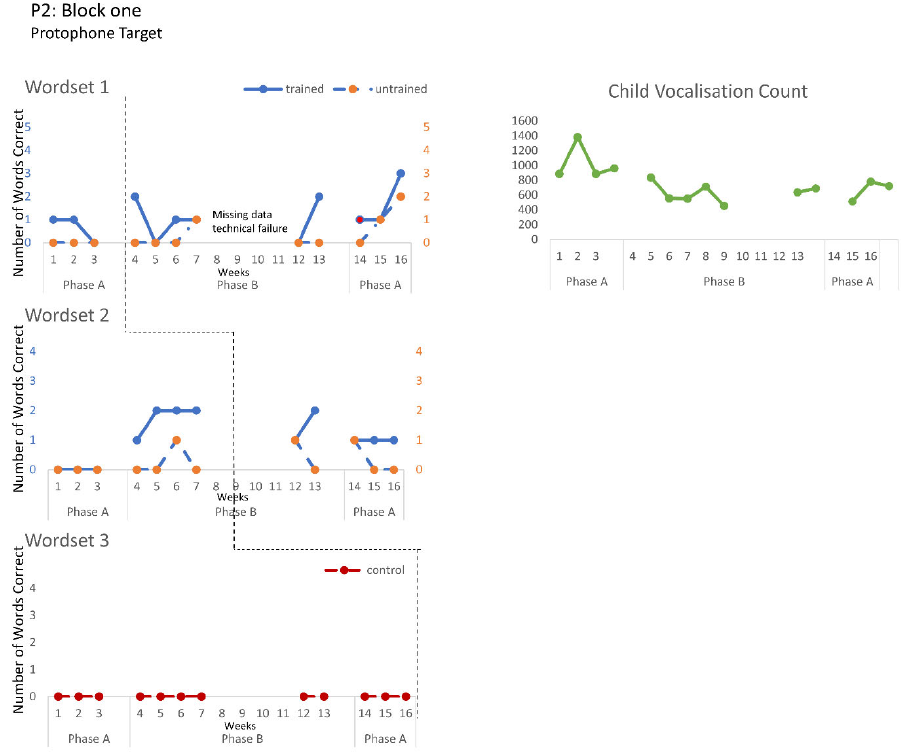
Figure 5. Accuracy of performance on the speech probes as scored for protophone target block one, participant 2 (vocalisation counts obtained from LENA device over same periods as block one).